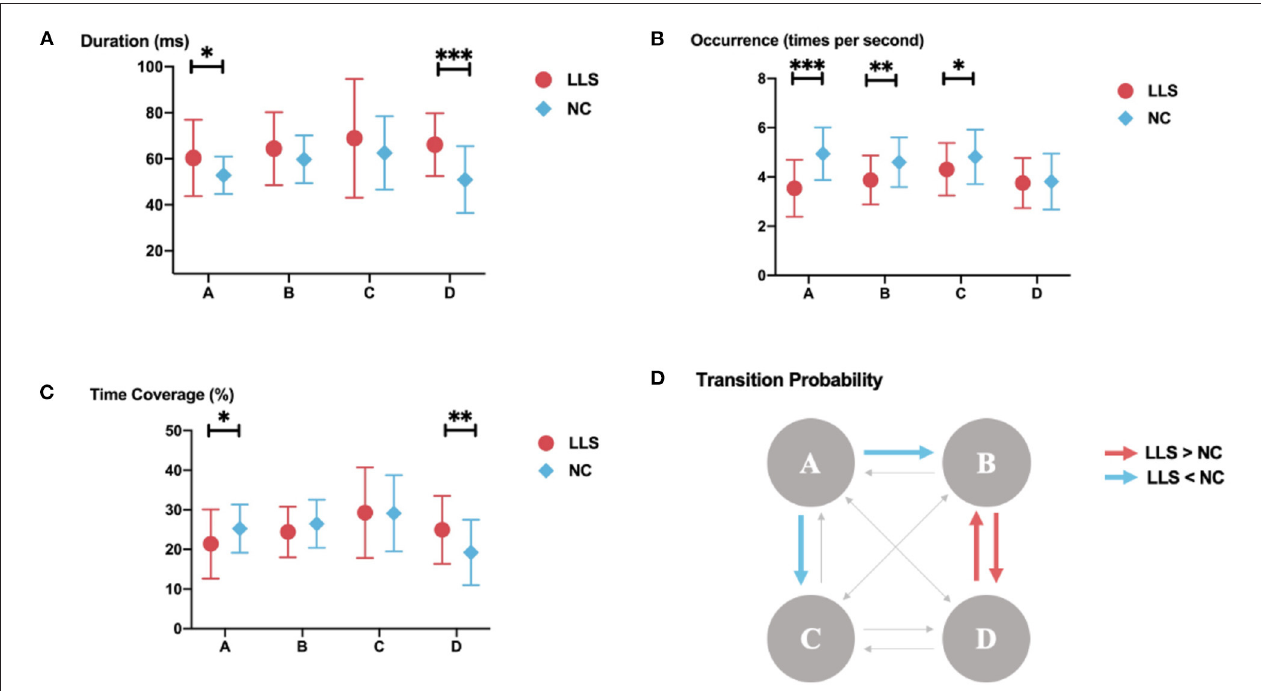
FIGURE 3 | Results of the microstate analysis for late-life schizophrenia (LLS) and normal controls (NCs). (A–C) microstate parameters for late-life schizophrenia and normal controls. (A) duration; (B) occurrence; (C) time coverage for late-life schizophrenia and normal controls. The parameters of each class are displayed from left to right. Red icons indicate parameters of late-life schizophrenia, blue icons indicate parameters of normal controls, and lines through icons indicate standard deviation. *indicates p- value ≤ 0.05, **indicates p- value ≤ 0.01, ***indicates p- value ≤ 0.001. (D) results of syntax analysis. Red arrows indicate significantly higher transition probabilities for patients with late-life schizophrenia compared with to controls. Blue arrows indicate significantly lower transition probabilities for patients with late-life schizophrenia compared with to controls.